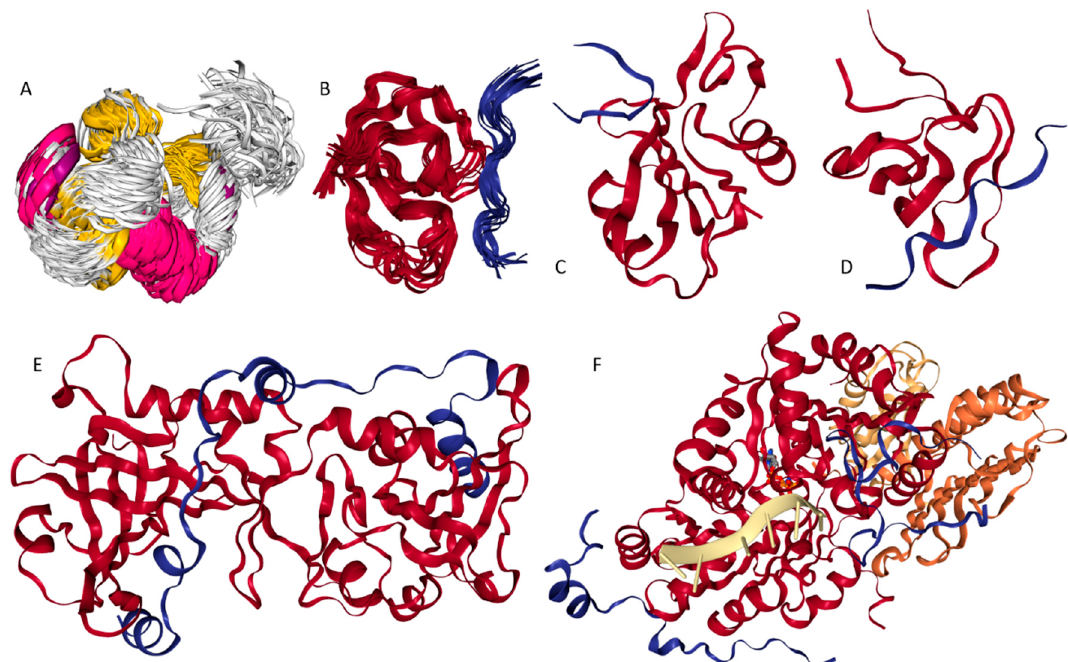
Figure 5. Structural characterization of highly connected ordered hubs. ( A ) Solution NMR structure of human ubiquitin (PDB ID: 1XQQ) [207]. ( B ) Solution NMR structure of a complex between the N-terminal SH3 domain of GRB2 (residues 1–56, red ribbons) and a peptide from SOS (blue ribbons)